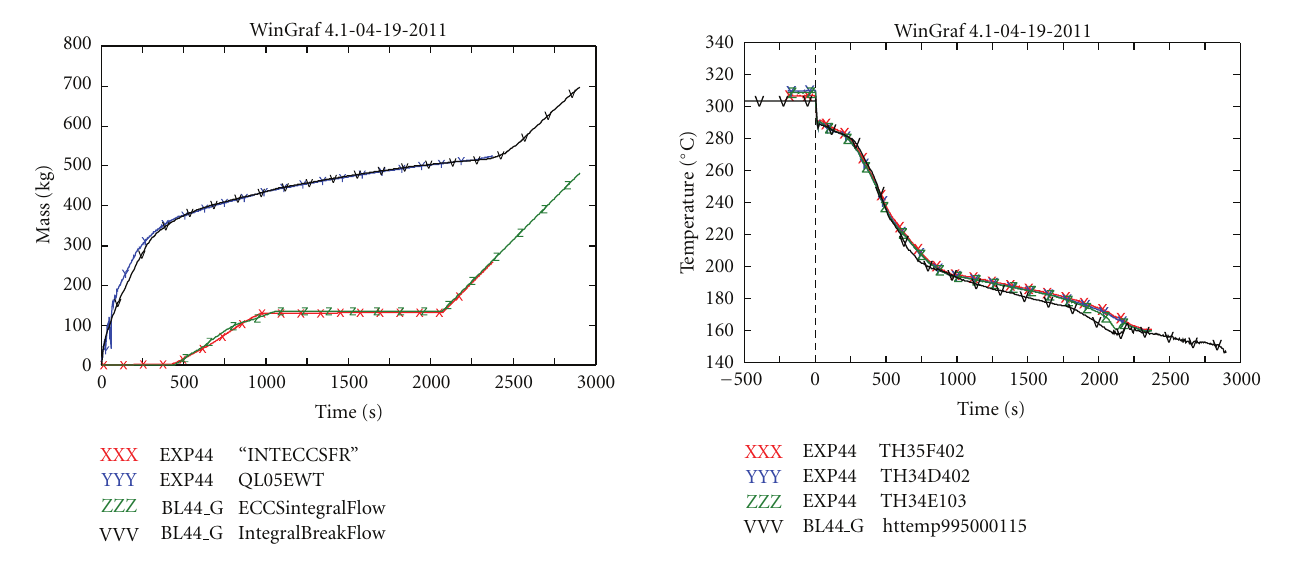
Figure 14: ECCS integral mass flow and integral break flow.